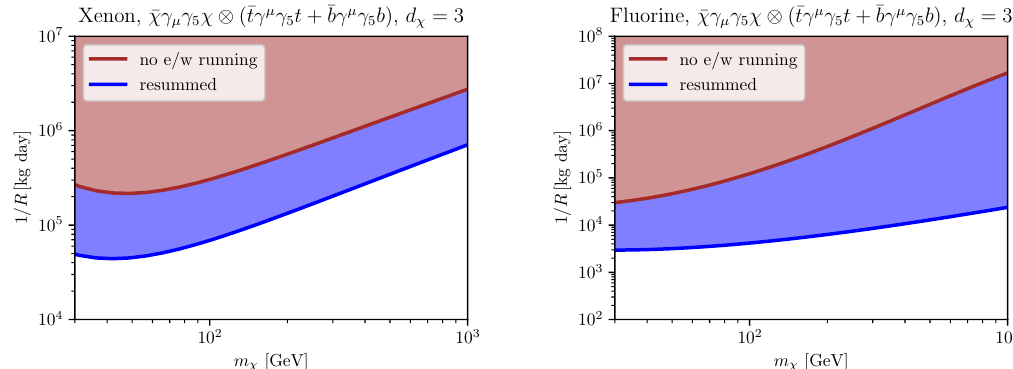
(cid:31) = 1 ; Y (cid:31) = 0